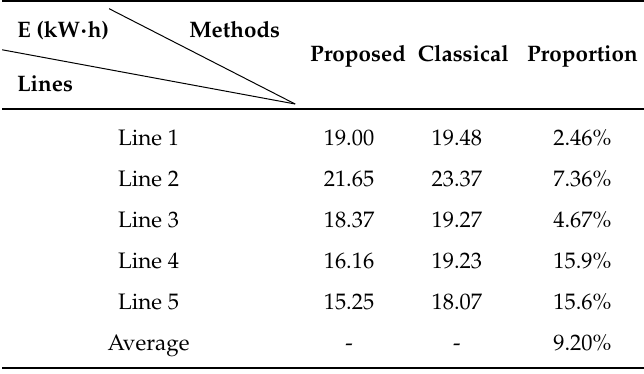
Table 7. Energy-saving performance comparisons for trains running in different